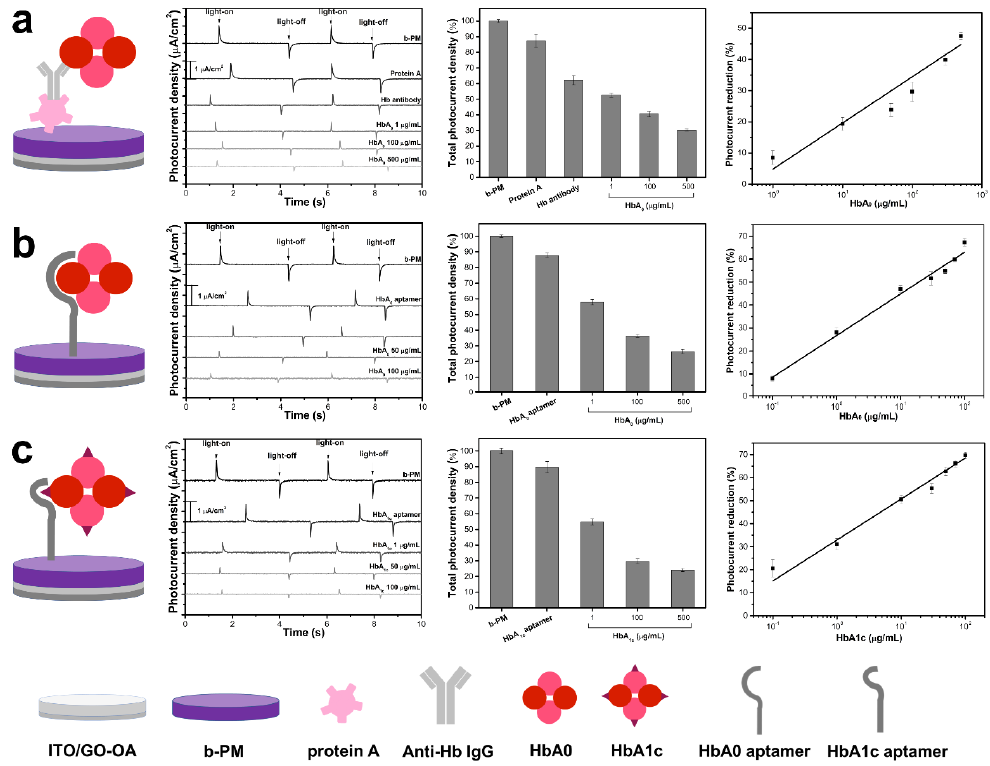
Figure 3. (Left) Structural schemes, (left center) typical photocurrent responses, (right center) total photocurrent density and (right) calibration curves for ( a ) Hb immunosensor, ( b ) HbA0 aptasensor and ( c ) HbA1c aptasensor. The left center and right center panels also show the data for chips that are fabricated using di ff erent top layers during the layer-by-layer sensor fabrication. All of the data in the right center and right panels is presented as the average value for three chips of a single type with one standard deviation (RSD <